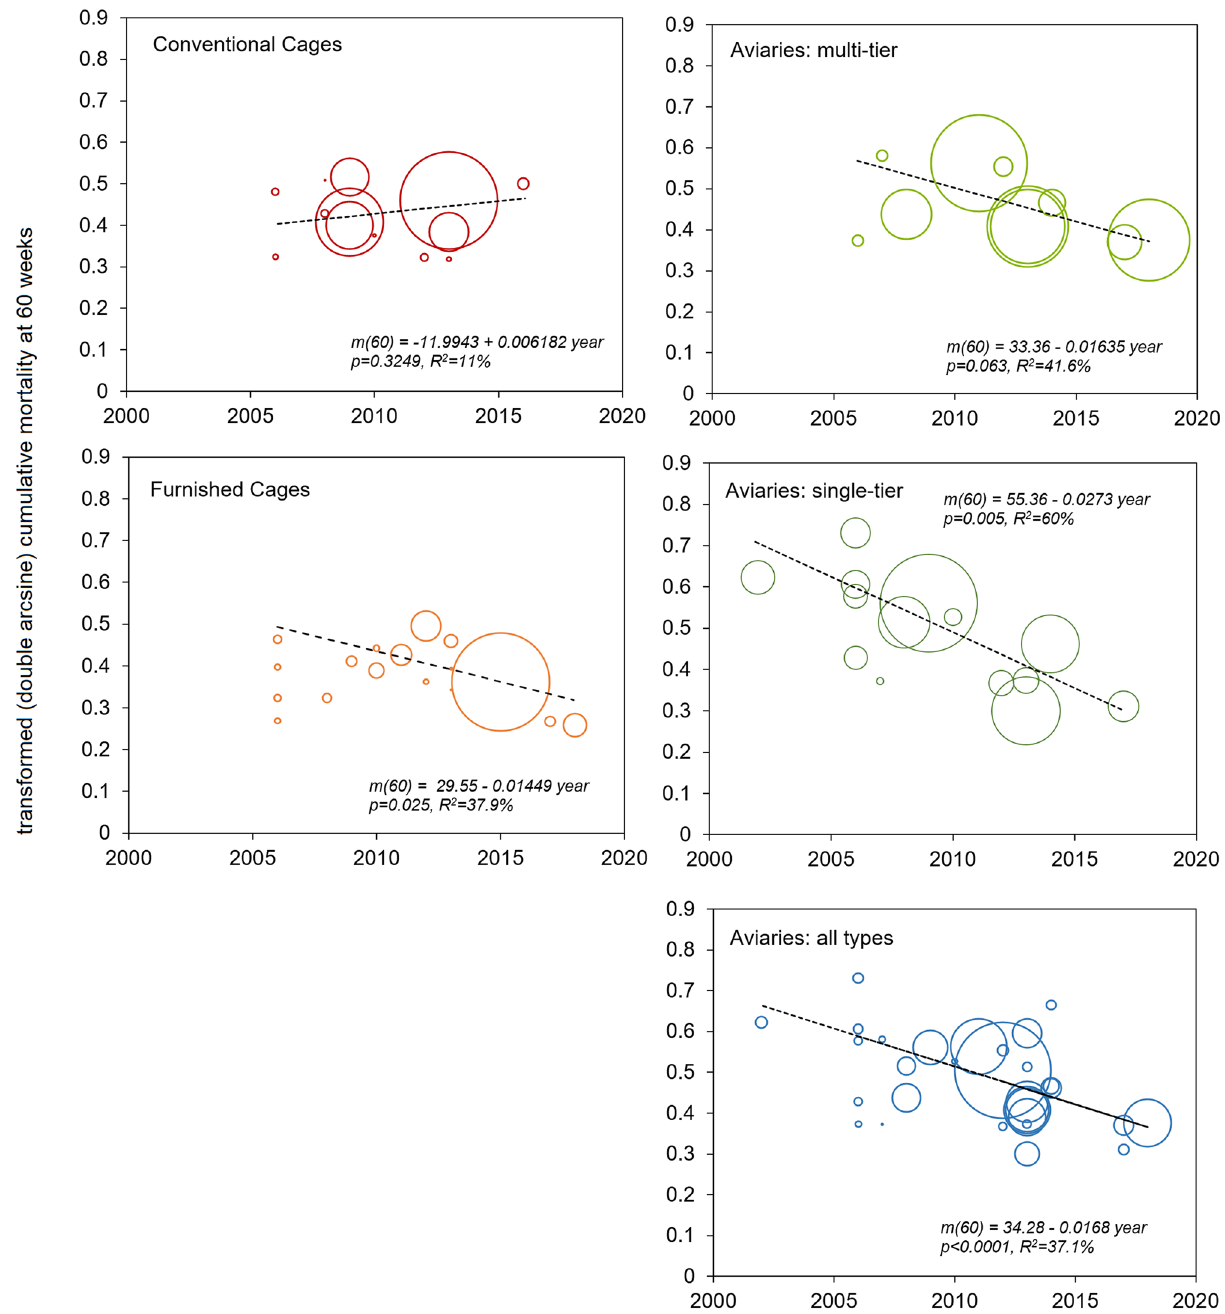
Figure 4. Meta-regression of cumulative layer mortality as a function of data collection year. Cumulative layer mortality at 60 weeks (m60, double arcsine transformed) in different commercially managed indoor housing systems. Regression equations and statistical results are shown in each corresponding graph. Each circle corresponds to one data source, with circle sizes representing the weights derived from the meta-analysis (see